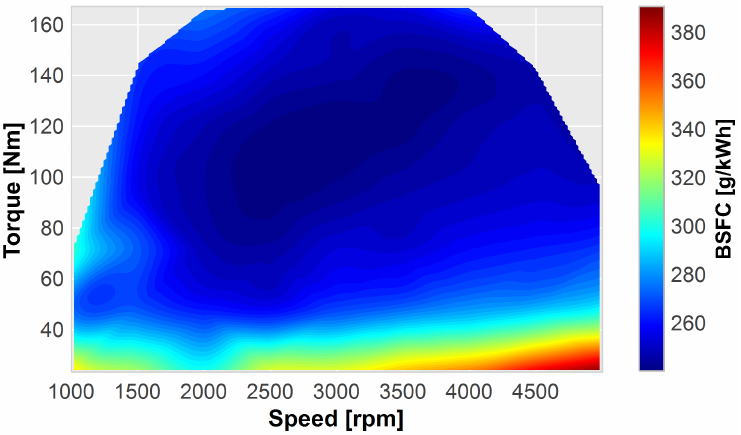
Figure 3. ICE fuel consumption 2D map depending on the engine speed and